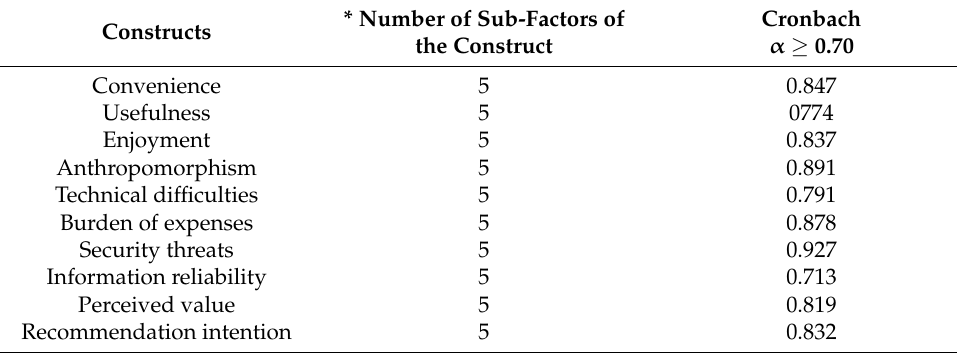
Table 4. Reliability analysis results for